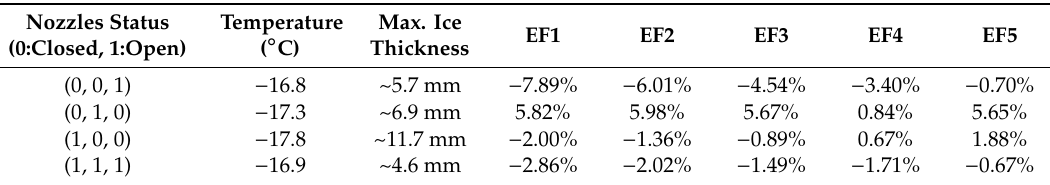
Table 3. Relative shift of the first five natural frequencies under different ice distributions, the values are peak estimates of the averaged response spectra.